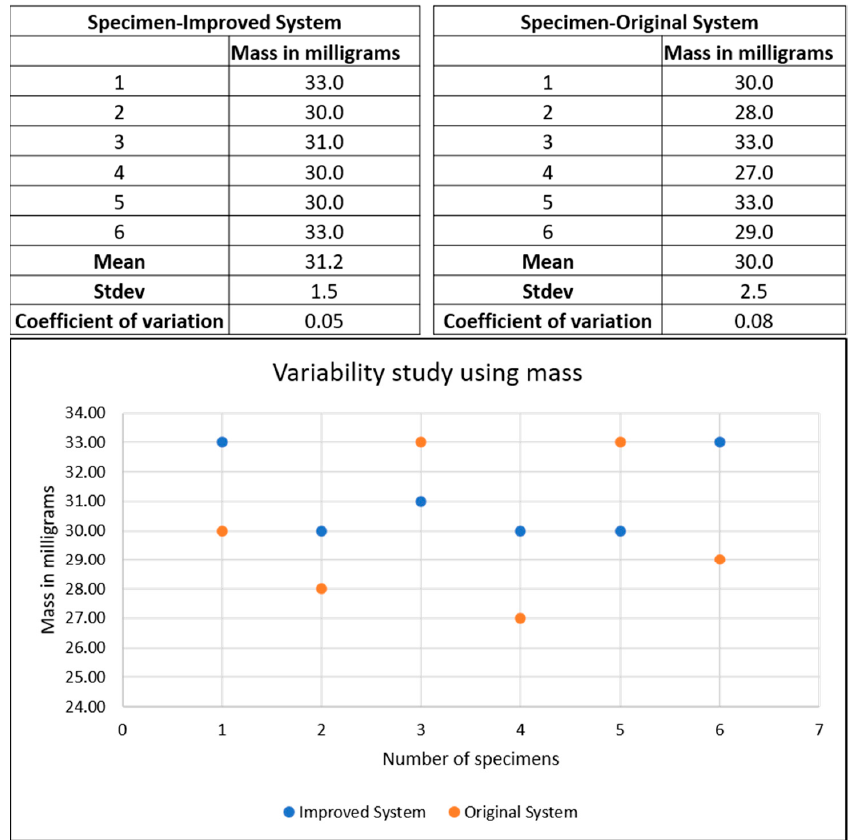
Figure 7. The improved system shows consistent mass distribution along the mat.